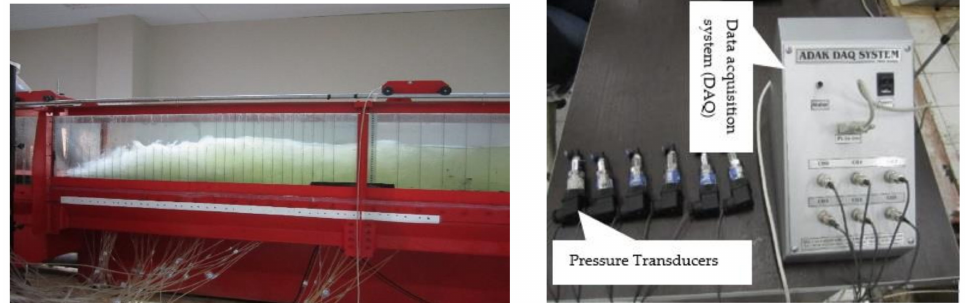
Figure 3. Pressure transducers connected via a 6-channel digital